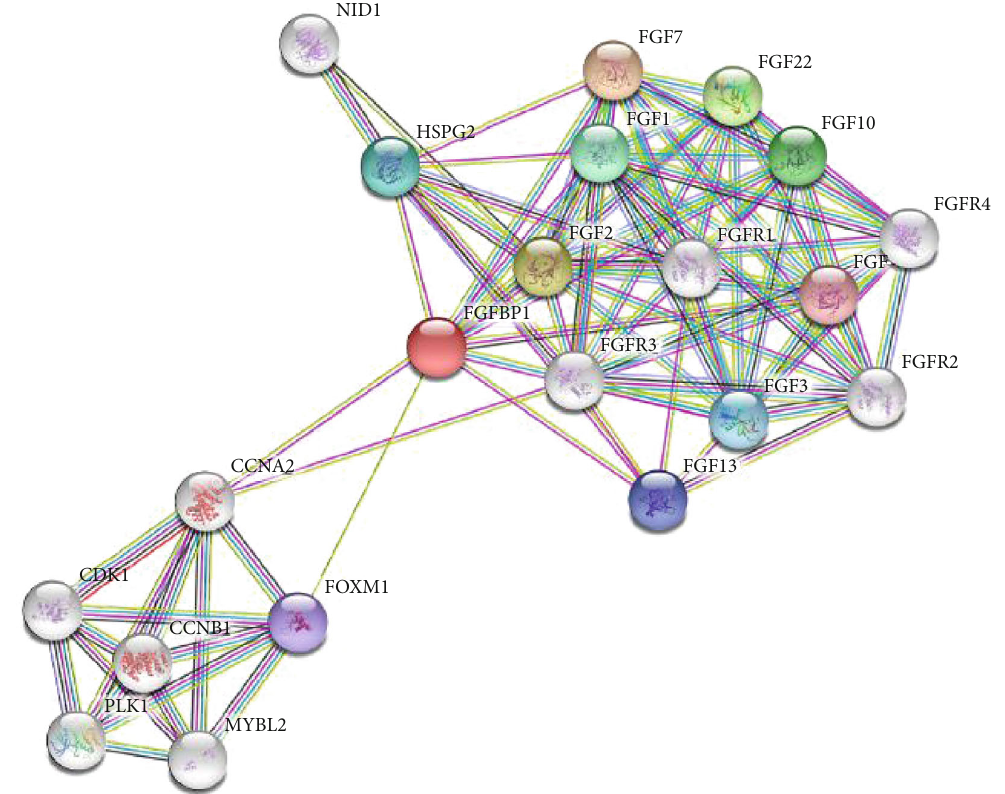
Figure 7: The connection diagram of FGF2, FGFR3, and